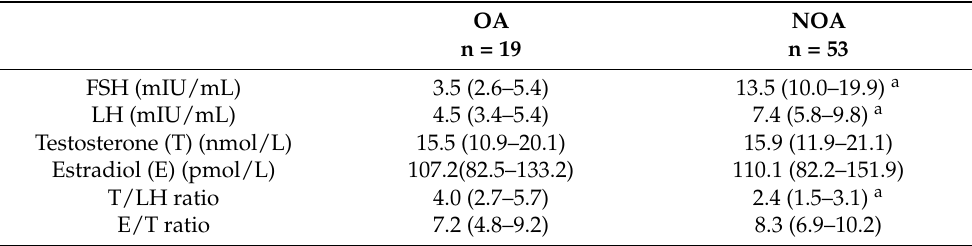
Table 4. Serum hormonal profile in the studied